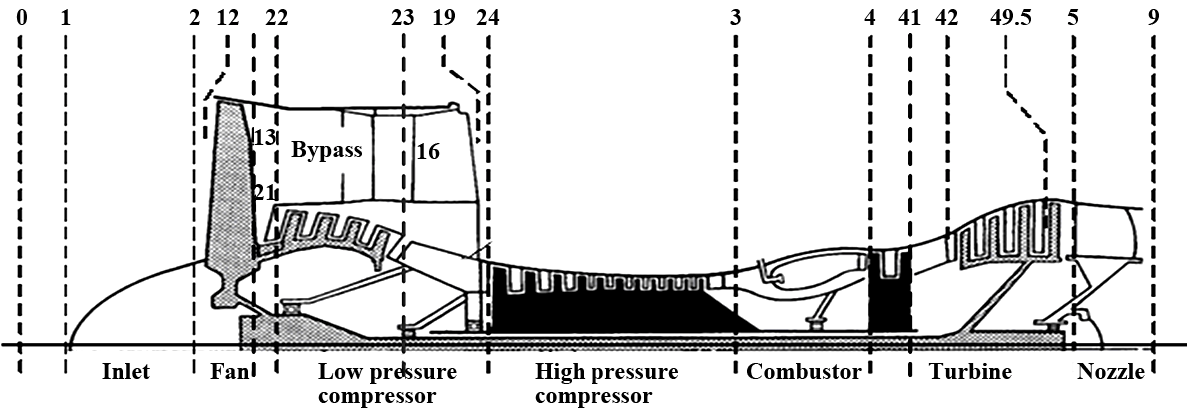
Figure 2. Schematic representation of a turbofan